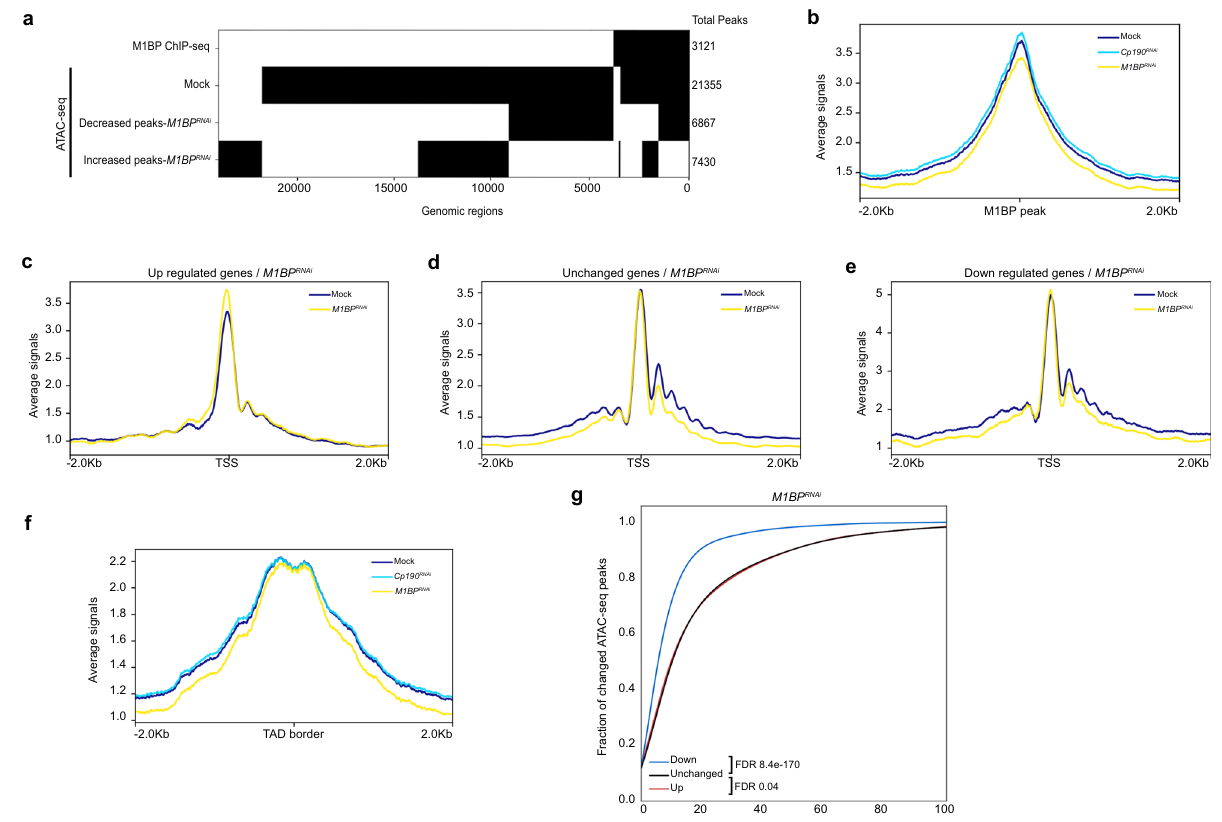
Fig. 9 Depletion of M1BP reduces the chromatin accessibility near TAD borders genome-wide. a Binary heatmap of M1BP ChIP-seq peaks, Mock ATAC- seq peaks, decreased and increased ATAC-seq peaks of M1BP RNAi compared to Mock ordered by supervised hierarchical clustering. Each row represents a single independent genomic location, and a black mark in a column represents the presence of a particular factor. b Average ATAC-seq tagmentation signals of Mock, M1BP RNAi and Cp190 RNAi cells for a 4 Kb. genomic window centered on M1BP-binding sites (ChIP-seq peaks). c Average ATAC-seq signals of Mock and M1BP RNAi cells for a 4 Kb genomic window centered on TSS of upregulated genes, d unchanged genes, and e downregulated genes in M1BP knockdown . f Average ATAC-seq signals of Mock, M1BP RNAi , and Cp190 RNAi cells are plotted for a 4 Kb genomic window centered at TAD borders. g Cumulative histograms of ATAC-seq peak center distance from closest TAD border classi fi ed by change in ATAC-seq peaks in M1BP knockdown cells relative to Mock. Decreased (blue), increased (red), or unchanged (black) ATAC-seq peaks are indicated. Mann – Whitney U test for each set of changed peaks against unchanged peaks is